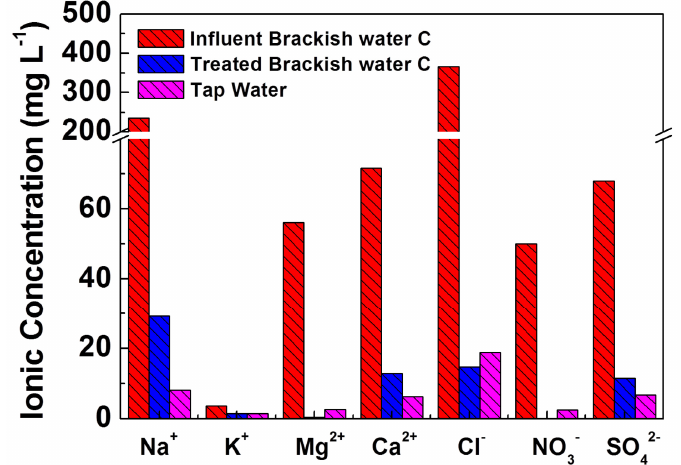
Figure 4. Comparison of individual ion concentrations between the influent/treated brackish water and tap water sampled at Virginia Tech. Reproduced with permission from reference